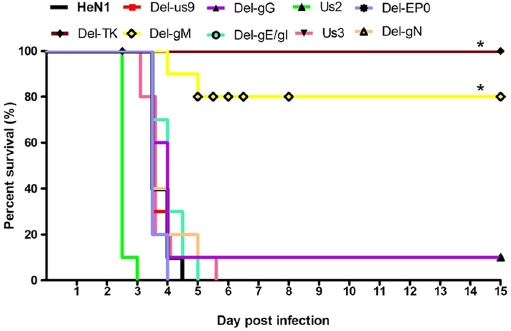
Figure 2. Pathogenicity of the indicated PRV mutants. Six- to eight-week-old female SPF BALB/c mice were divided into 11 groups, and each group was infected with HeN1 or the indicated PRV mutant via subcutaneous injection with 2 × 10 4 PFUs of each virus or DMEM (100 μ L). Survival was recorded for 15